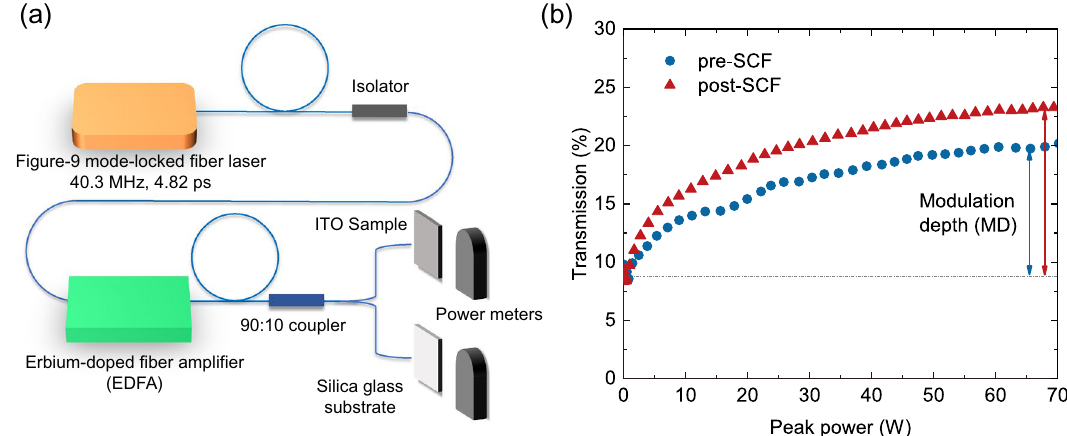
Figure 3. Enhancement of the SA characteristics. ( a ) Scheme of the fiber laser SA testing system. ( b ) Saturable absorption characteristics of the SCF-processed